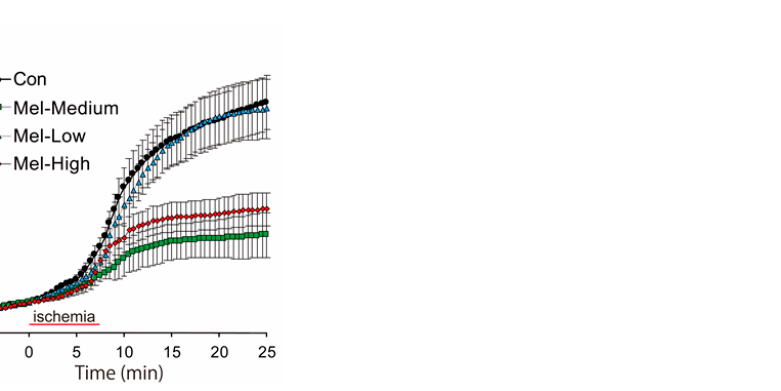
Figure 2. ( A ) Representative traces of spontaneous excitatory postsynaptic currents (sEPSCs) for control (upper) and melatonin (lower) groups (100 µ M) during pre-ischemic, ischemic and reperfusion periods. In each trace, sEPSCs caused by synaptic glutamate releases are seen as transient downward deflections (inward currents). For both control and melatonin groups, occurrences of sEPSCs began to increase approximately 7 min after ischemic perfusion. In traces of the control group, an explosive increase in frequencies of sEPSCs were observed 2 min after reperfusion. In contrast, for the melatonin group, increased occurrences of sEPSCs quickly receded to pre-ischemic levels after reperfusion. ( B ) Time course of cumulative sEPSCs that occurred in control and melato- nin-induced PostC groups. Cumulative sEPSCs that occurred were expressed as a percentage of the total number of sEPSCs occurring in the 5 min prior to ischemia under low (10 μ M), medium (100 μ M), and high (1 mM) concentrations of melatonin perfusion. In each group, the majority of sEPSCs occurred in the first 5 min after reperfusion. The timeline in the graph set to 0 min at the start for the ischemic load. In each group, the cumulative sEPSCs at 0 min of timeline were set as 100%. ( C ) Each vertical rectangle and error bar indicate percent cumulative sEPSCs that occurred at 20 min after onset of ischemic perfusion (12.5 min after reperfusion) and standard error of the mean (SEM), respectively. Asterisks indicate significant difference in t-test (** p < 0.01). Con—control; Mel—mel- atonin.